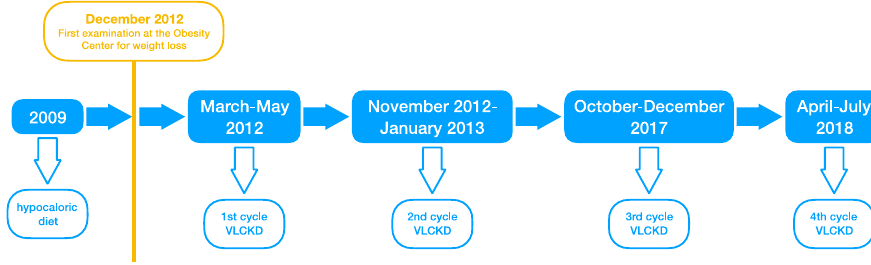
Figure 1. Timeline of the dietary interventions followed by the subject.